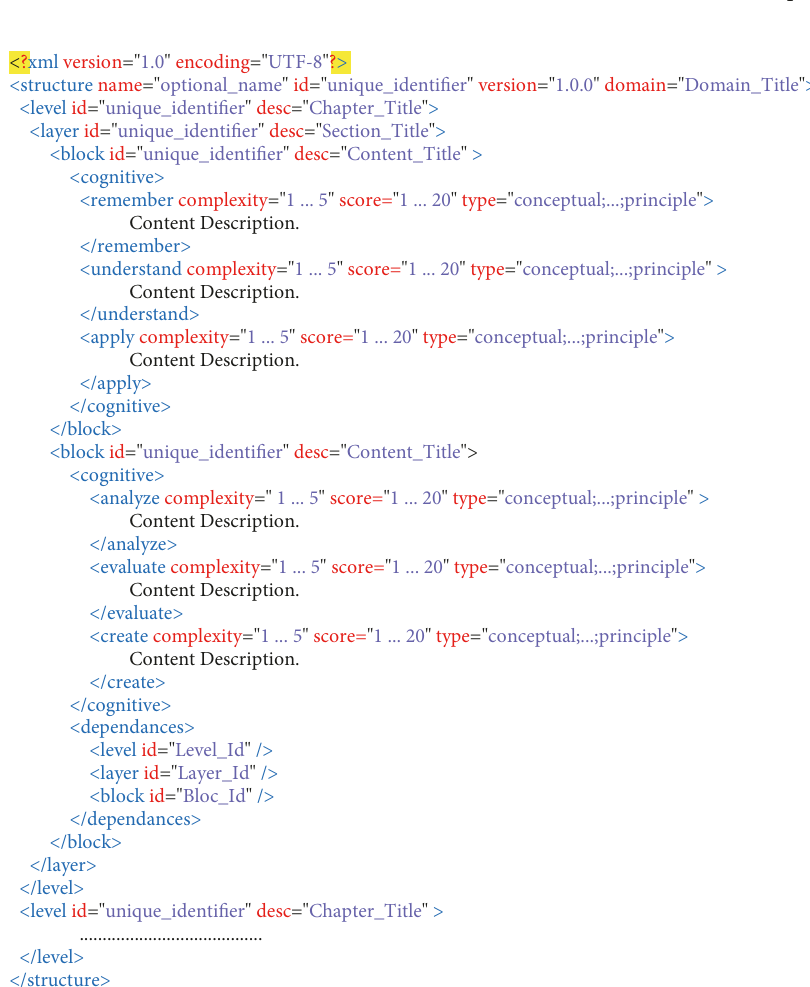
Figure 6: A proposal for domain content specifications, designed using XML (Extensible Markup Language) to represent domain content specifications, in which the hierarchy is structured by level close to chapter, layer to section, and block to subsection. The block is composed of a cognitive tag that contains the required learning function and its attributes in addition to the dependences tag which refers to the previous block, layer, or level; in the case that the block depends on a given layer or level, it is necessary to review all blocks that contain these